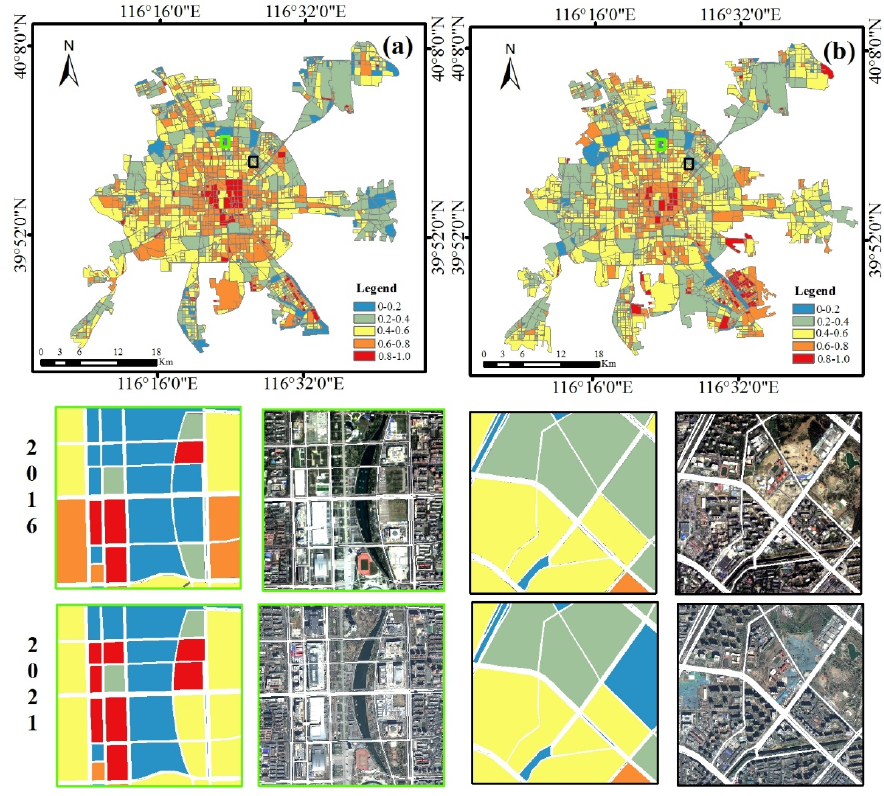
Figure 9. ( a , b ) show the results of the building coverage ratio in Beijing in 2016 and 2021, respectively. Note: the green and black boxes represent the detailed comparison results of the building coverage ratio and GaoFen-1 images for the two regions during 2016–2021.